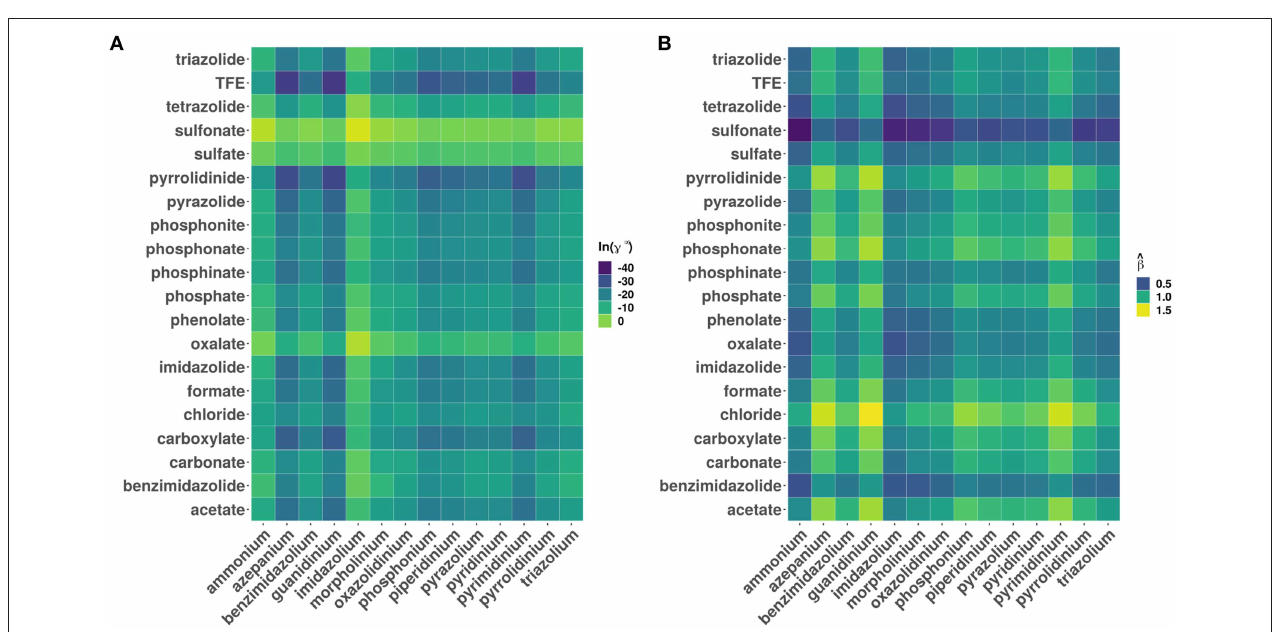
FIGURE 3 | Scatter plot of ˆ β predicted by the MLR model and COSMO-RS estimates of the infinite dilution activity coefficients ( γ ∞ ) of multicrystalline cellulose in various ionic liquids.